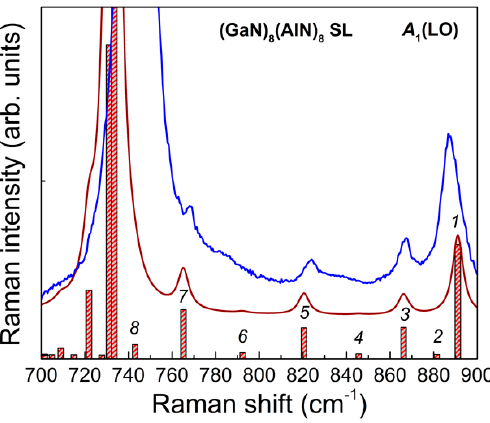
Figure 12. Frequencies and Raman intensities of the A 1 (LO) symmetry modes in the calculated spectrum in the z ( xx ) z geometry for (GaN) 8 /(AlN) 8 SLs (shown by bars). The solid brown line shows the averaged spectrum for the Lorentzian line shape and the line half-width of 3 cm − 1 . The blue line shows the experimental spectrum.